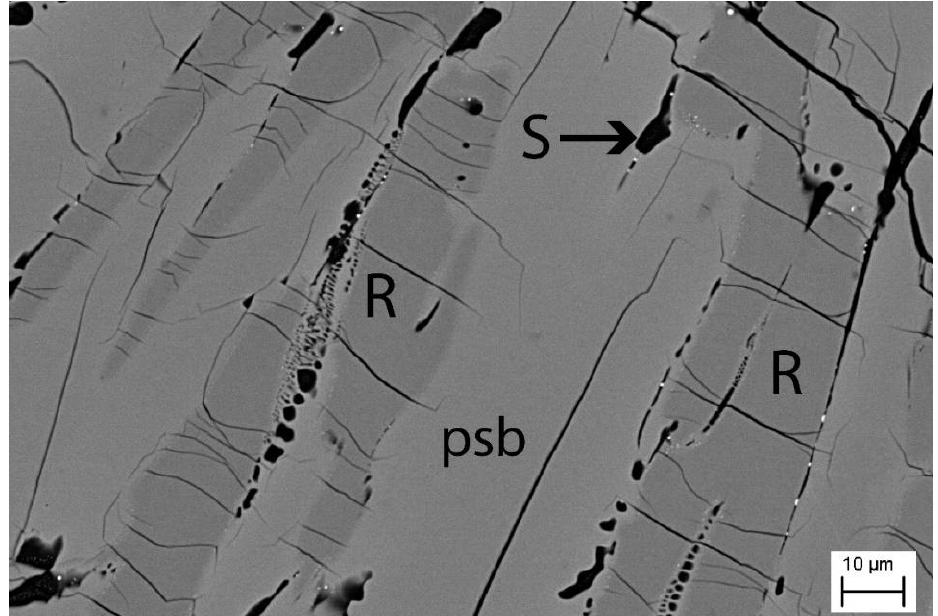
Figure 7. Microstructures of slag sample 1 analyzed by scanning electron microscopy (SEM). The rutile phase is represented as R, the silicate phase as S, and the pseudobrookite phase as psb.